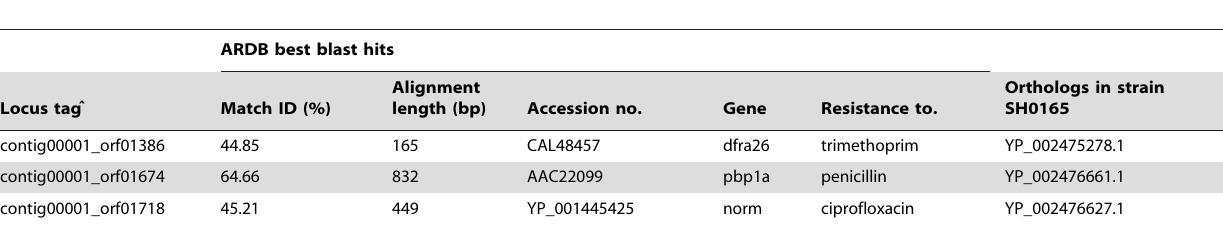
Table 6. Identification of drug resistant genes of H. parasuis strain ZJ0906 and comparison with strain SH0165.